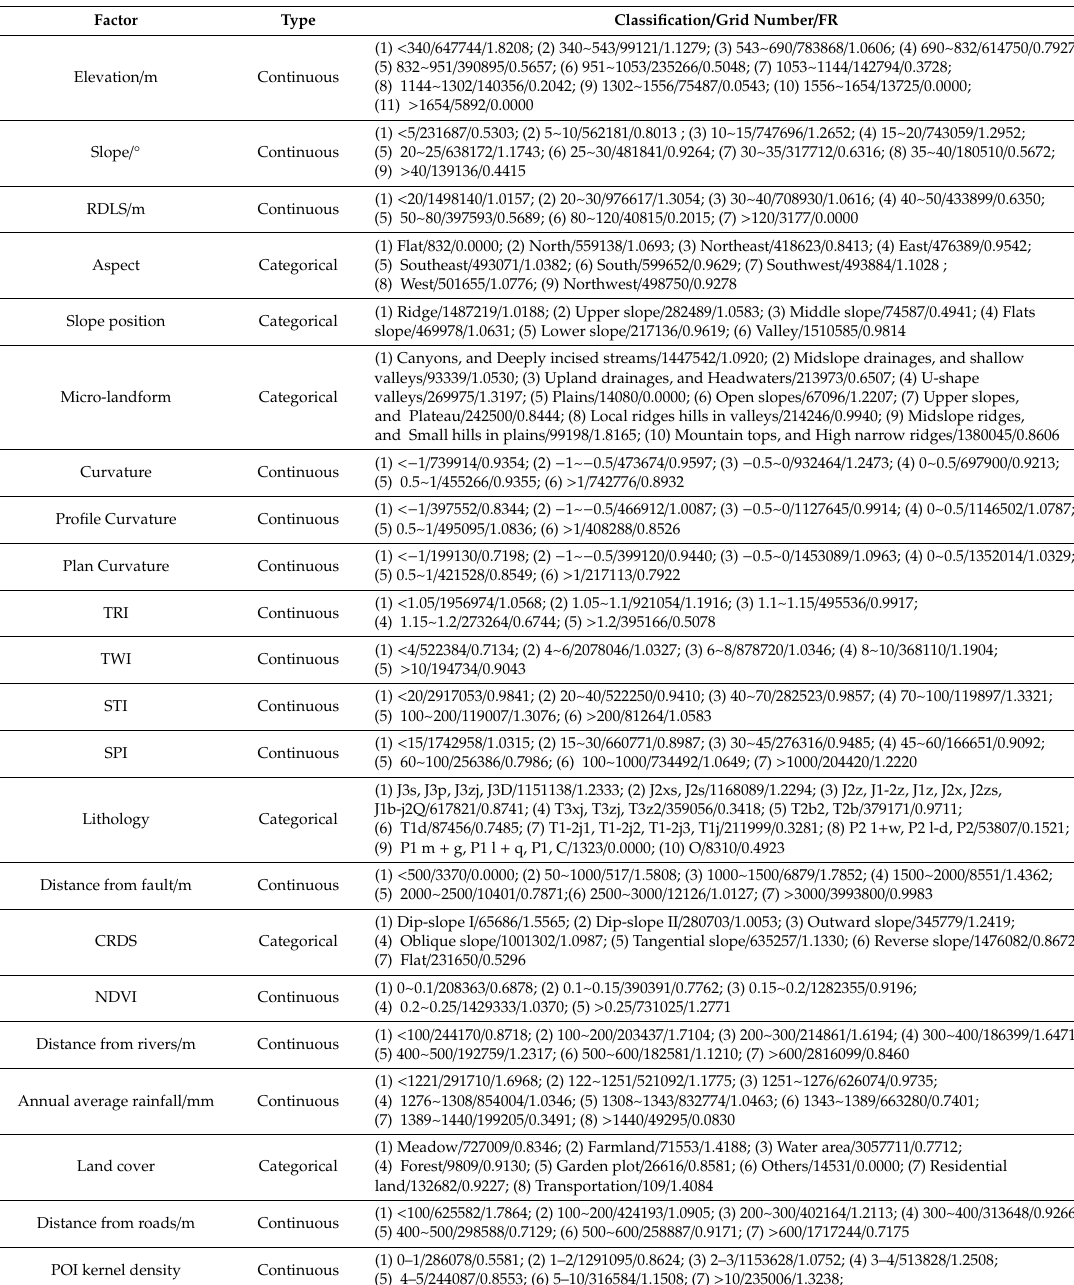
Table 6. Classification and FR of conditioning